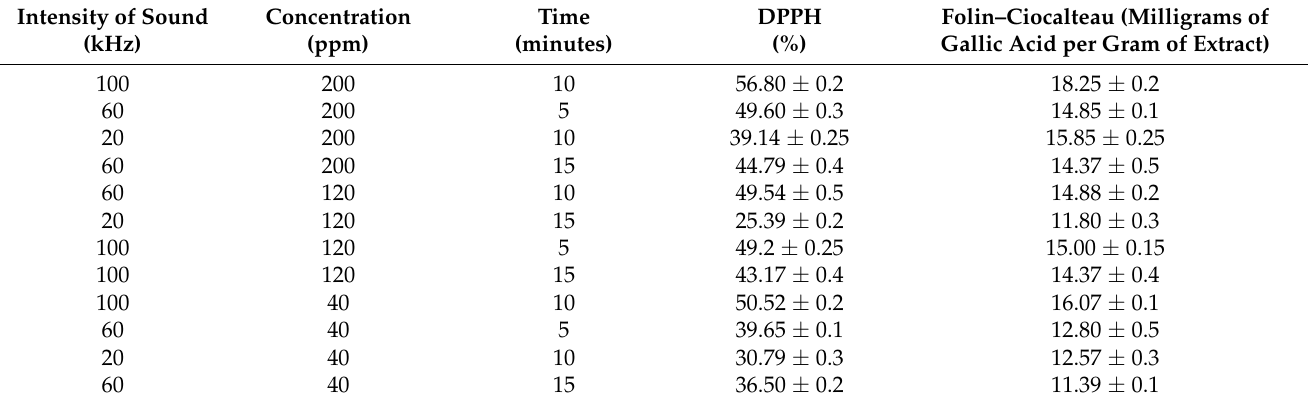
Table 2. Matrix of design experiments with